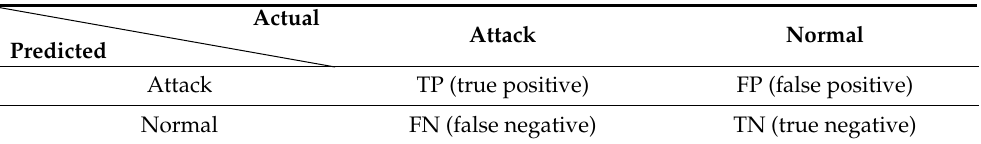
Table 1. Confusion